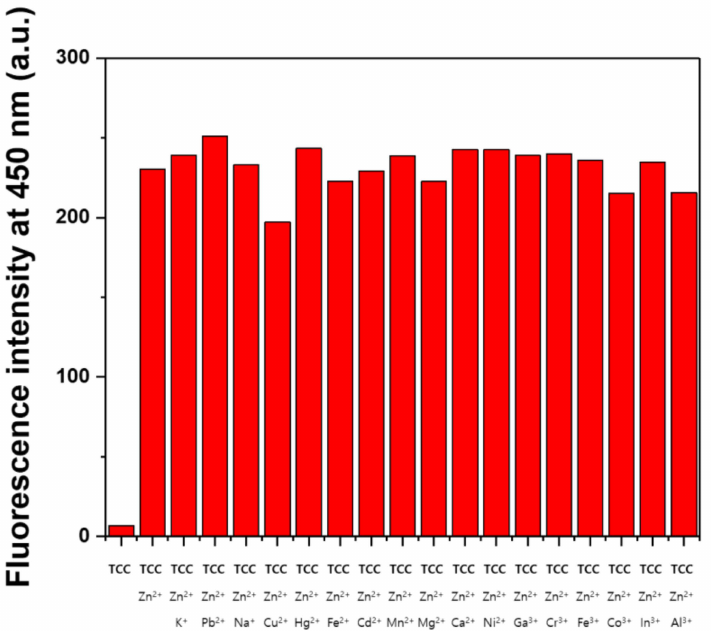
Figure 6. The fluorescence intensity for the reaction of TCC (4.0 × 10 − 5 M) at 450 nm with the addition of Zn 2+ (1.6 equiv) with/without other metal ions (1.6 equiv; λ ex = 320